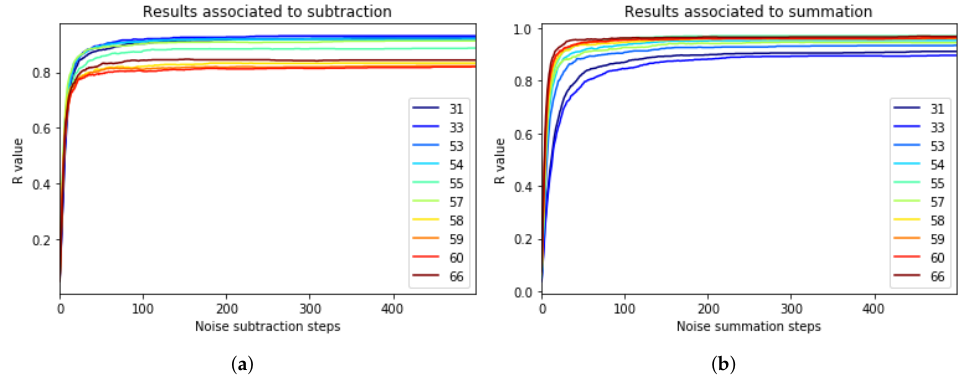
Figure 6. Monitoring of ( a ) R ( k , m sub , c 0 ) and ( b ) R ( k , m sum , c 0 ) during the noise addition